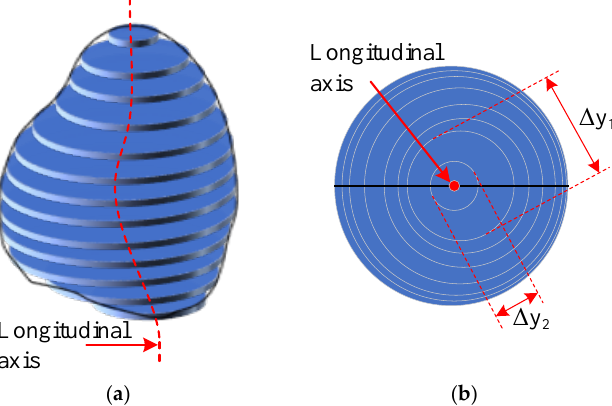
Figure 8. The layering of an ellipse: ( a ) side view of an ellipse model; ( b ) top view of ellipse model.